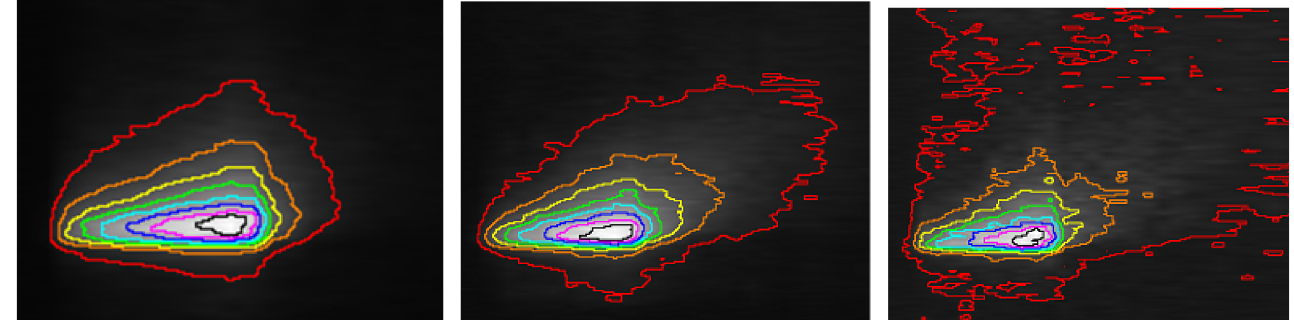
FIG. 8. (Color) Gas cloud imaged in blue, green, and red. Shown are contours of constant light intensity.